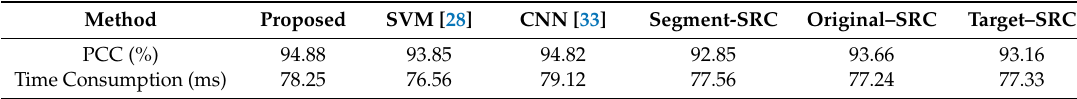
Table 4. Recognition performance of the proposed method under SOC.